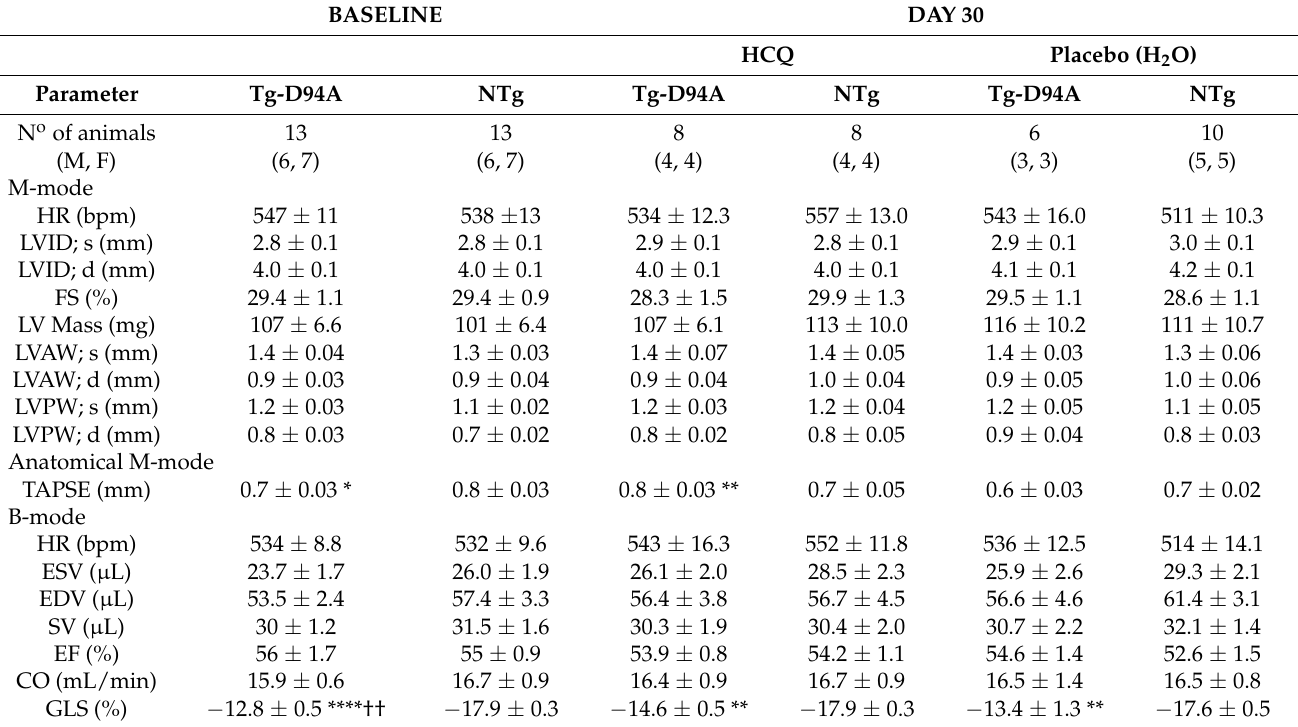
Table 1. Doppler echocardiographic evaluation of Tg-D94A and NTg mice at baseline and 30 days after treatment with HCQ or